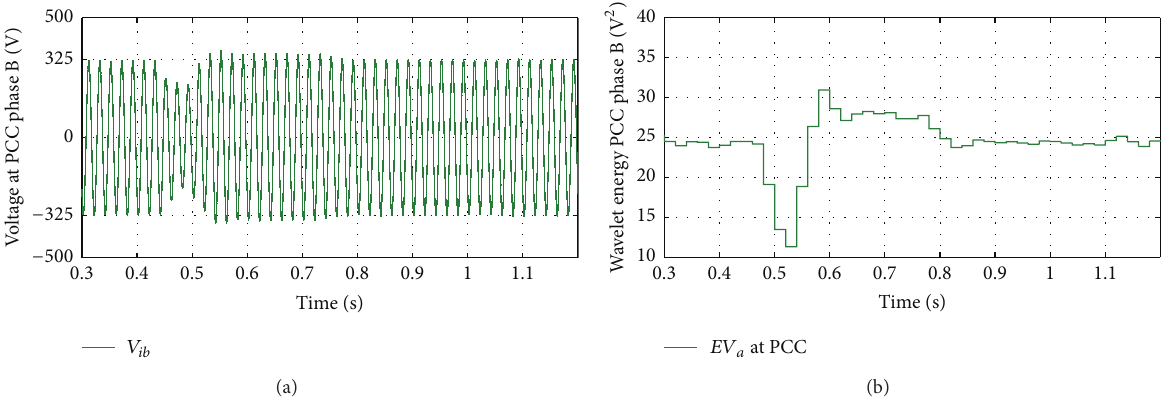
Figure 20: (a) Voltage signal and (b) wavelet energy plot at PCC for phase B.